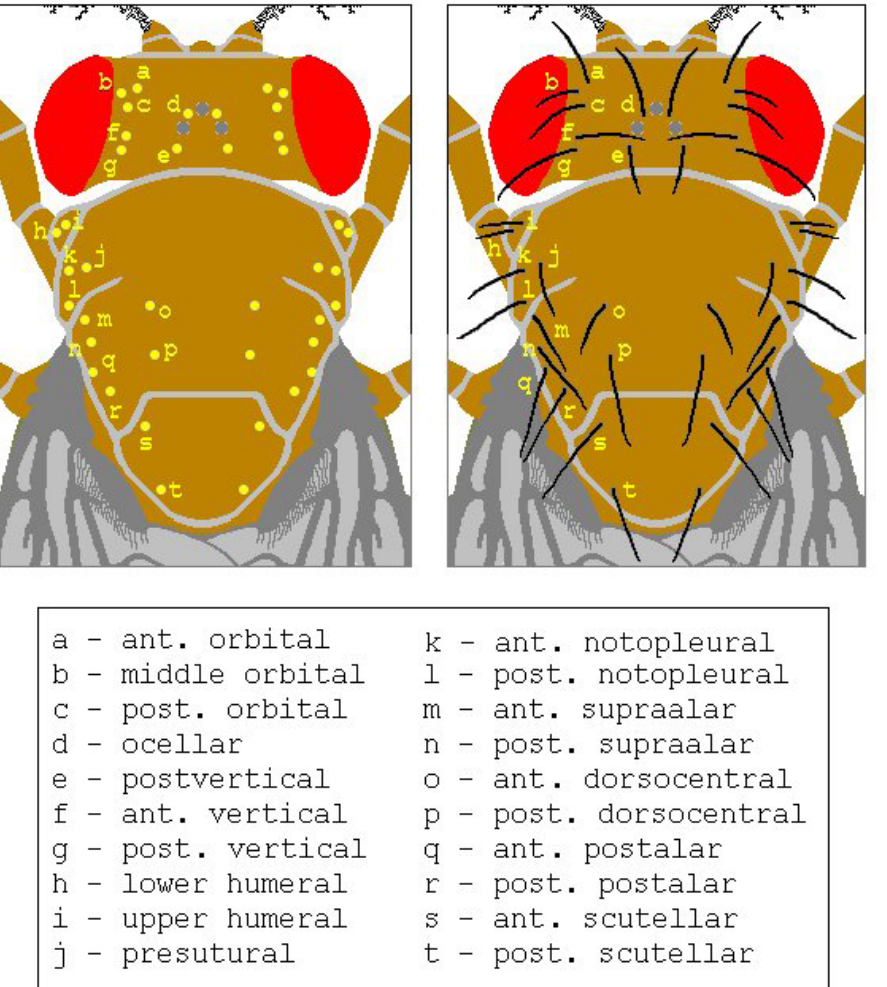
Figure 2 - Main head and thorax bristles (details in the text and box above).